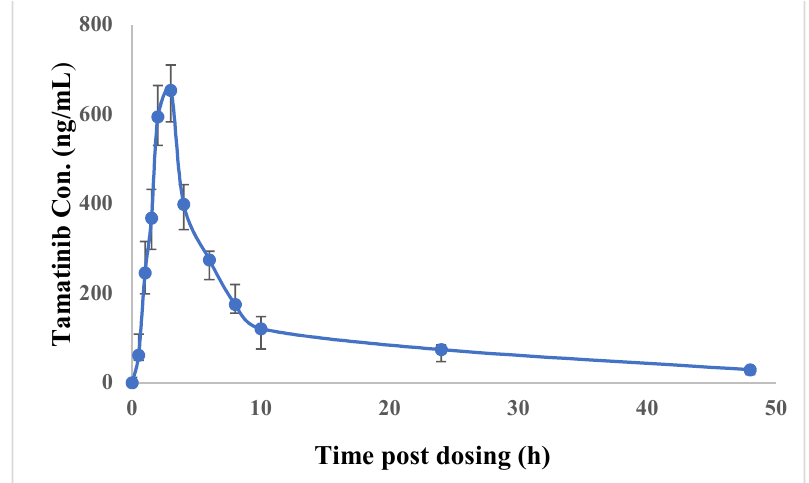
Figure 5. The Time Profile of Tamatinib Concentrations (Mean ± SD) after Oral Administration of 12.5 mg/kg of Fostamatinib.